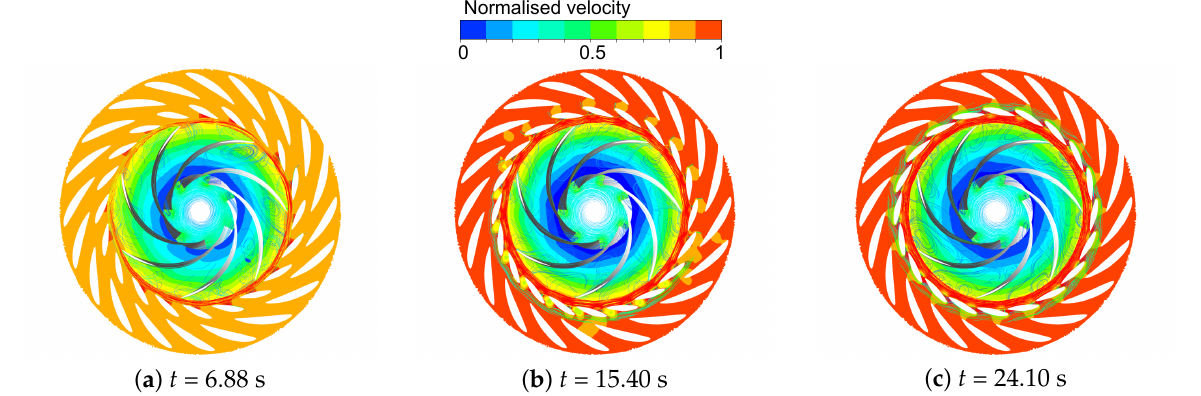
Figure 11. The streamline distribution of the unit at three key time moments.